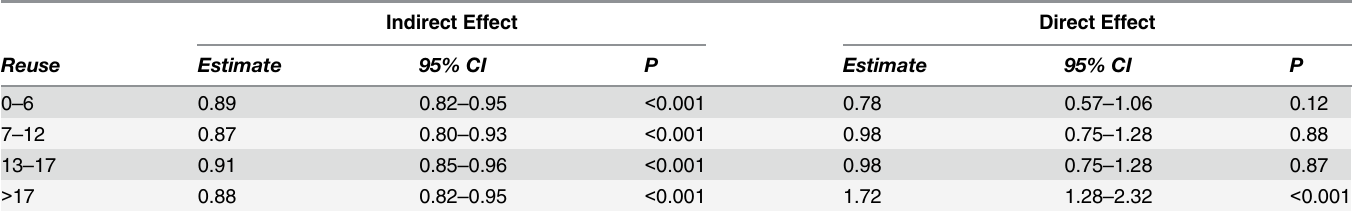
Table 4. Joint Model estimates of Adjusted Hazard Ratios for All Cause Mortality associated with the use of High Flux vs. Low Flux Dialyzers under different extents of